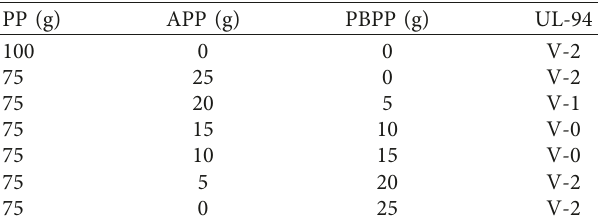
Figure 8: TG (a) and DTG (b) curves of IFR-PP with different charring agents in air. Table 1: Effect of different ratios of APP to PBPP on flame Table 2: Effect of IFR addition on flame retardancy of retardancy of PP.